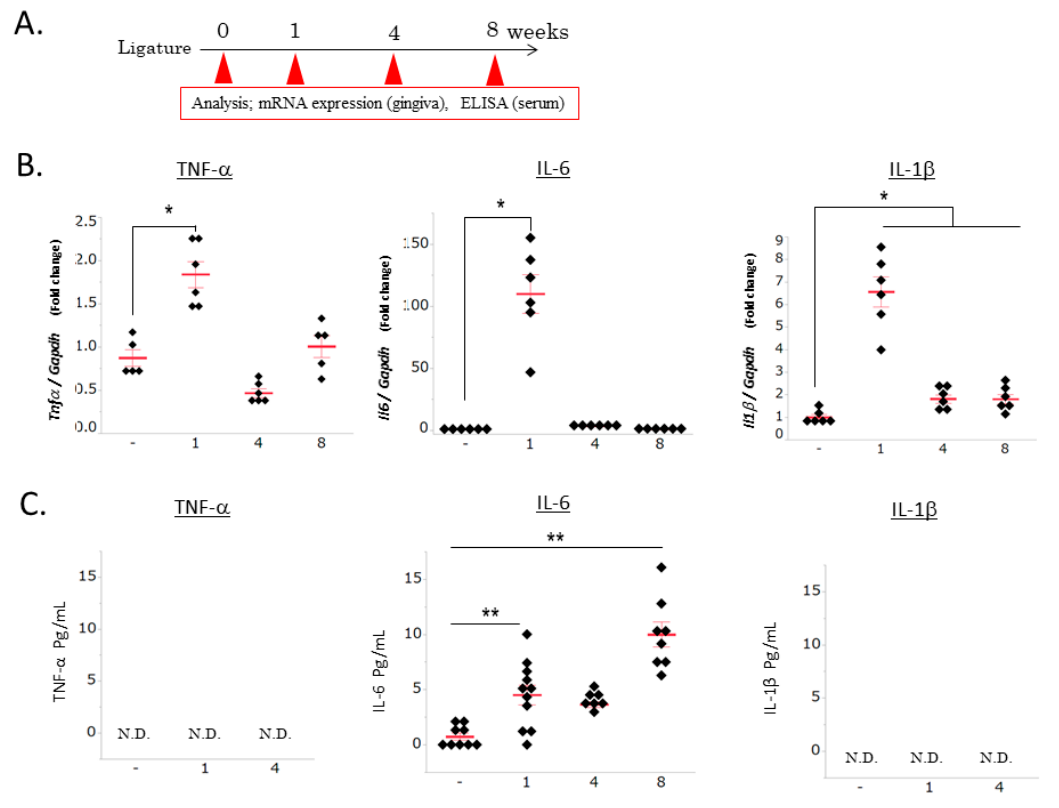
Figure 1. Ligature-induced periodontal inflammation and increased serum IL-6 cytokine levels. ( A ) Schedule of analysis of cytokine mRNA expression levels in the gingiva and protein levels in serum. ( B ) Time course of proinflammatory cytokine mRNA expression in gingival tissue (mean ± SE, n = 5–